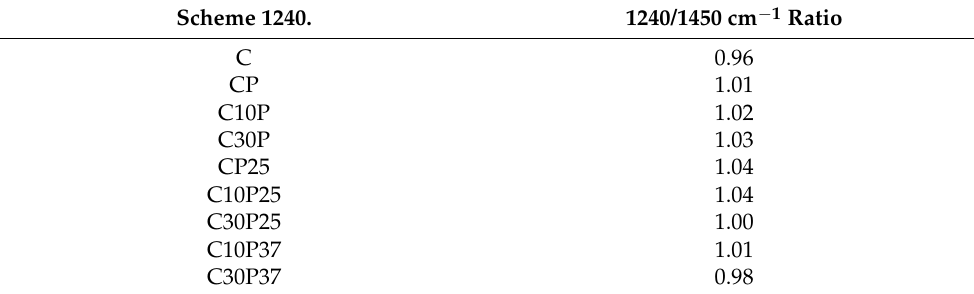
Table 1. FTIR band intensity ratio.